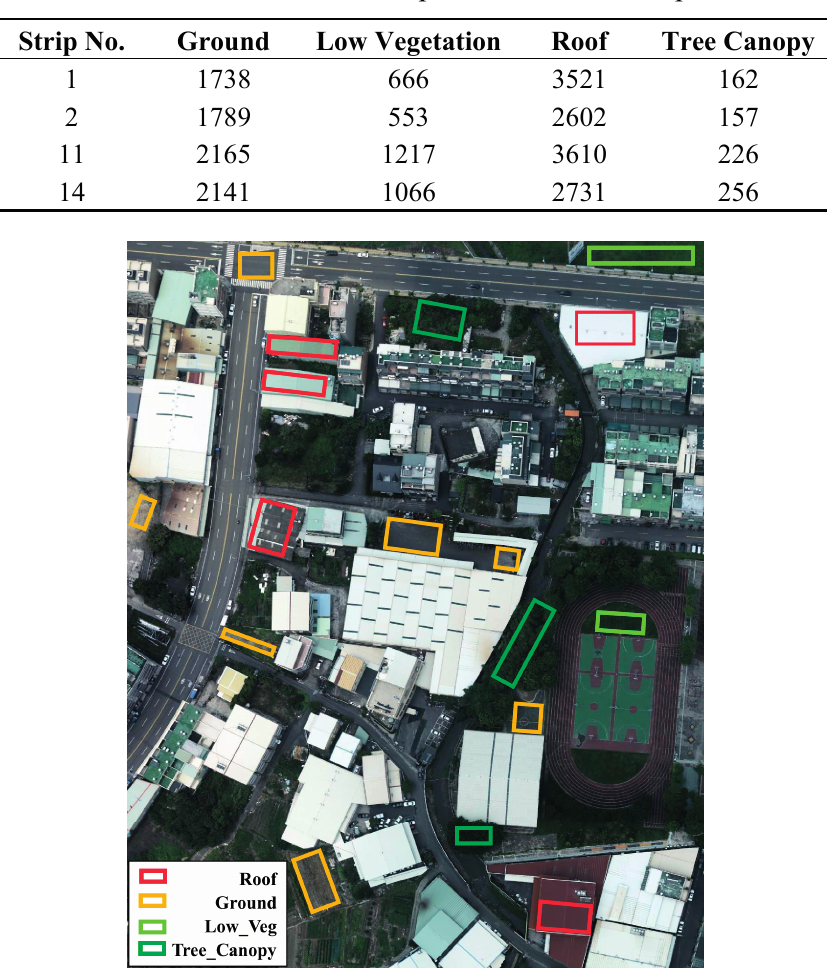
Figure 8. Distribution of samples for four land cover